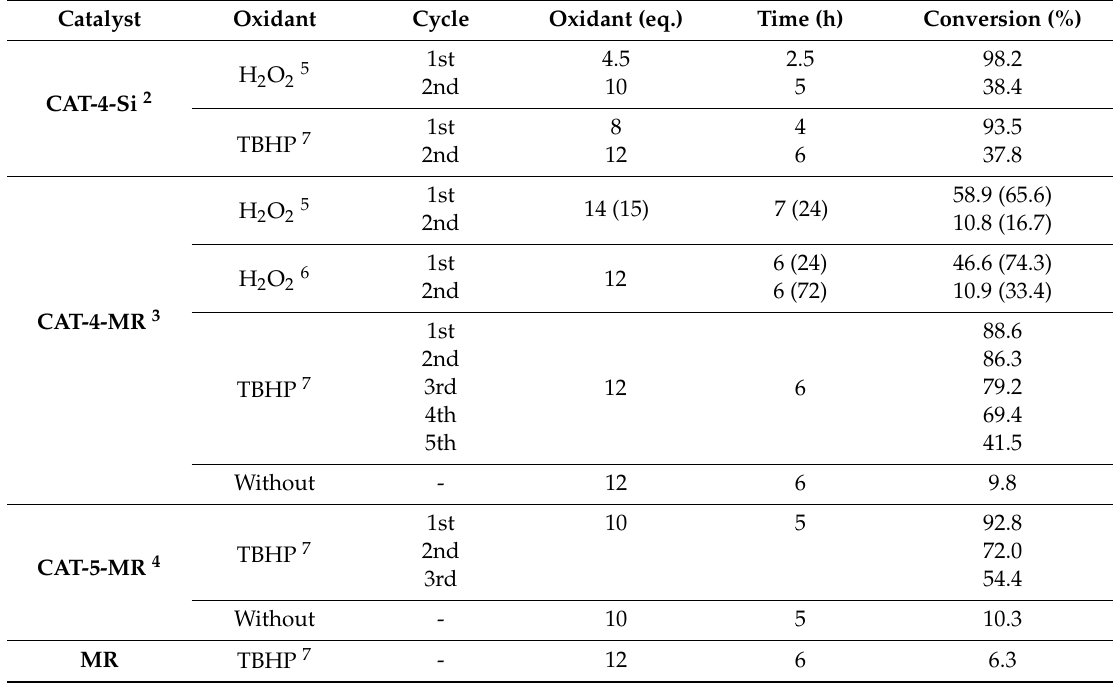
Table 3. Results obtained for the oxidation of cyclooctene catalysed by CAT-4-Si , CAT-4-MR or CAT-5-MR 1 .